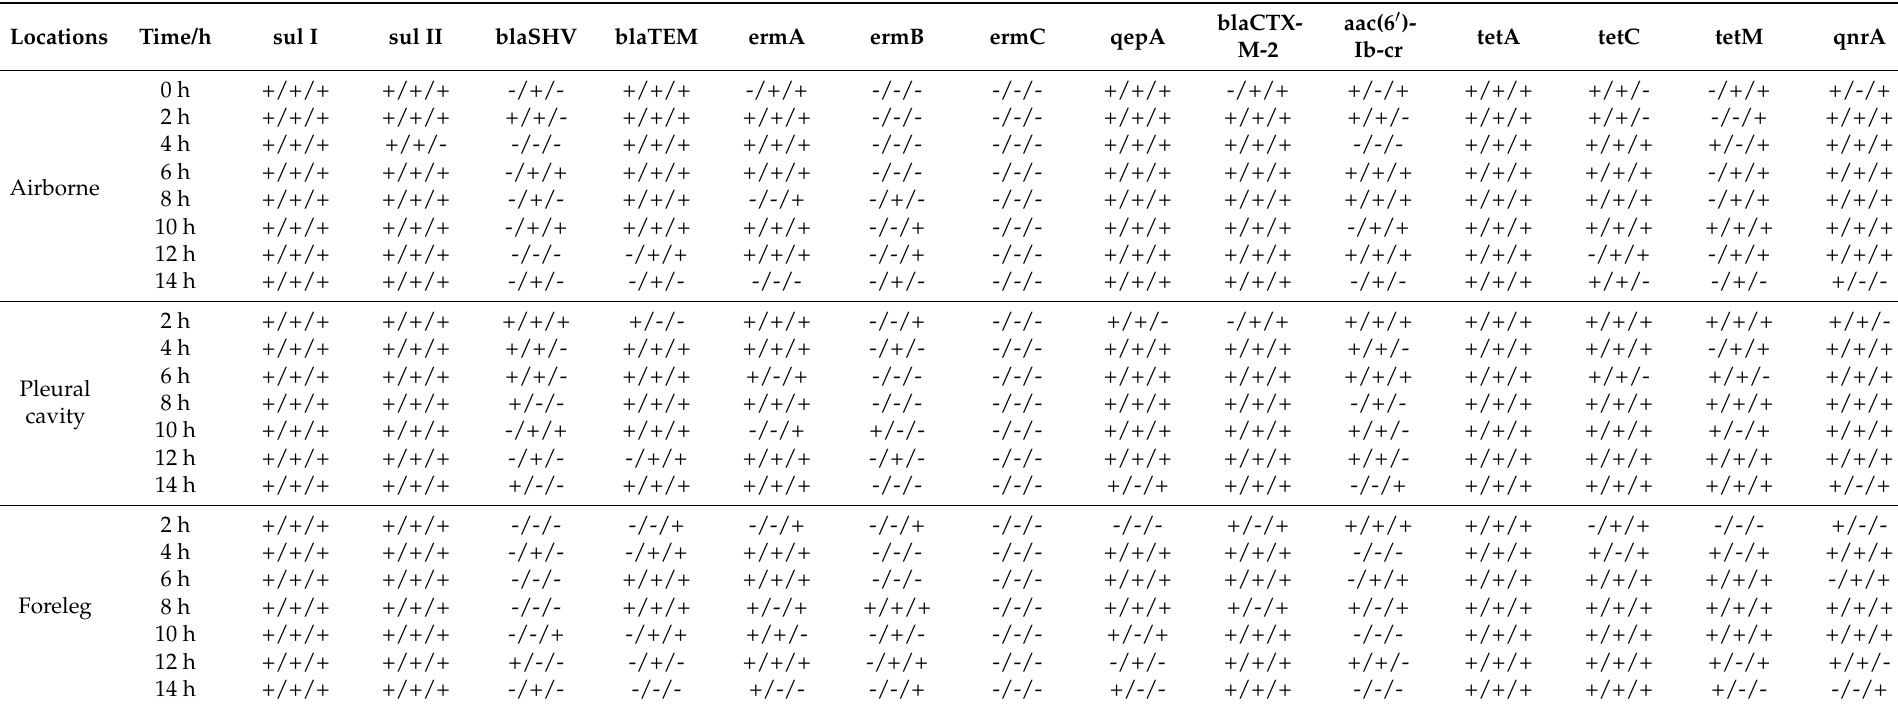
Table 4. Incidence of drug-resistant genes in microbiota samples from the air and the surface of pleural cavity and